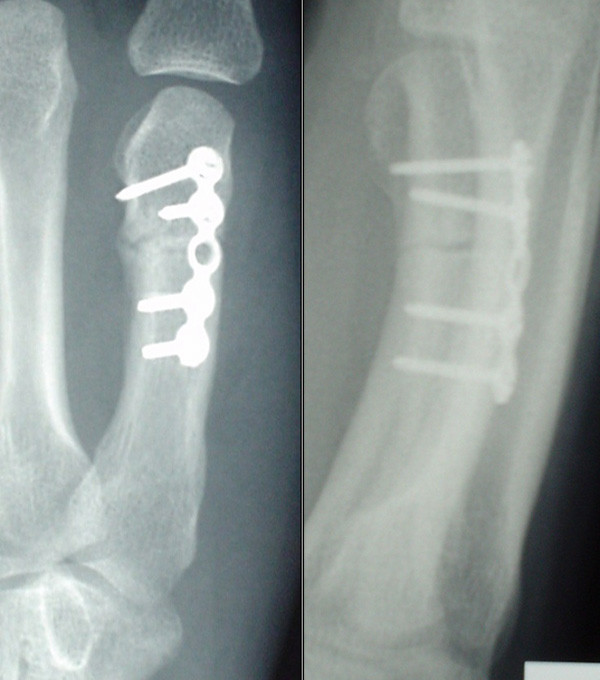
The correction obtained with closing wedge osteotomy.